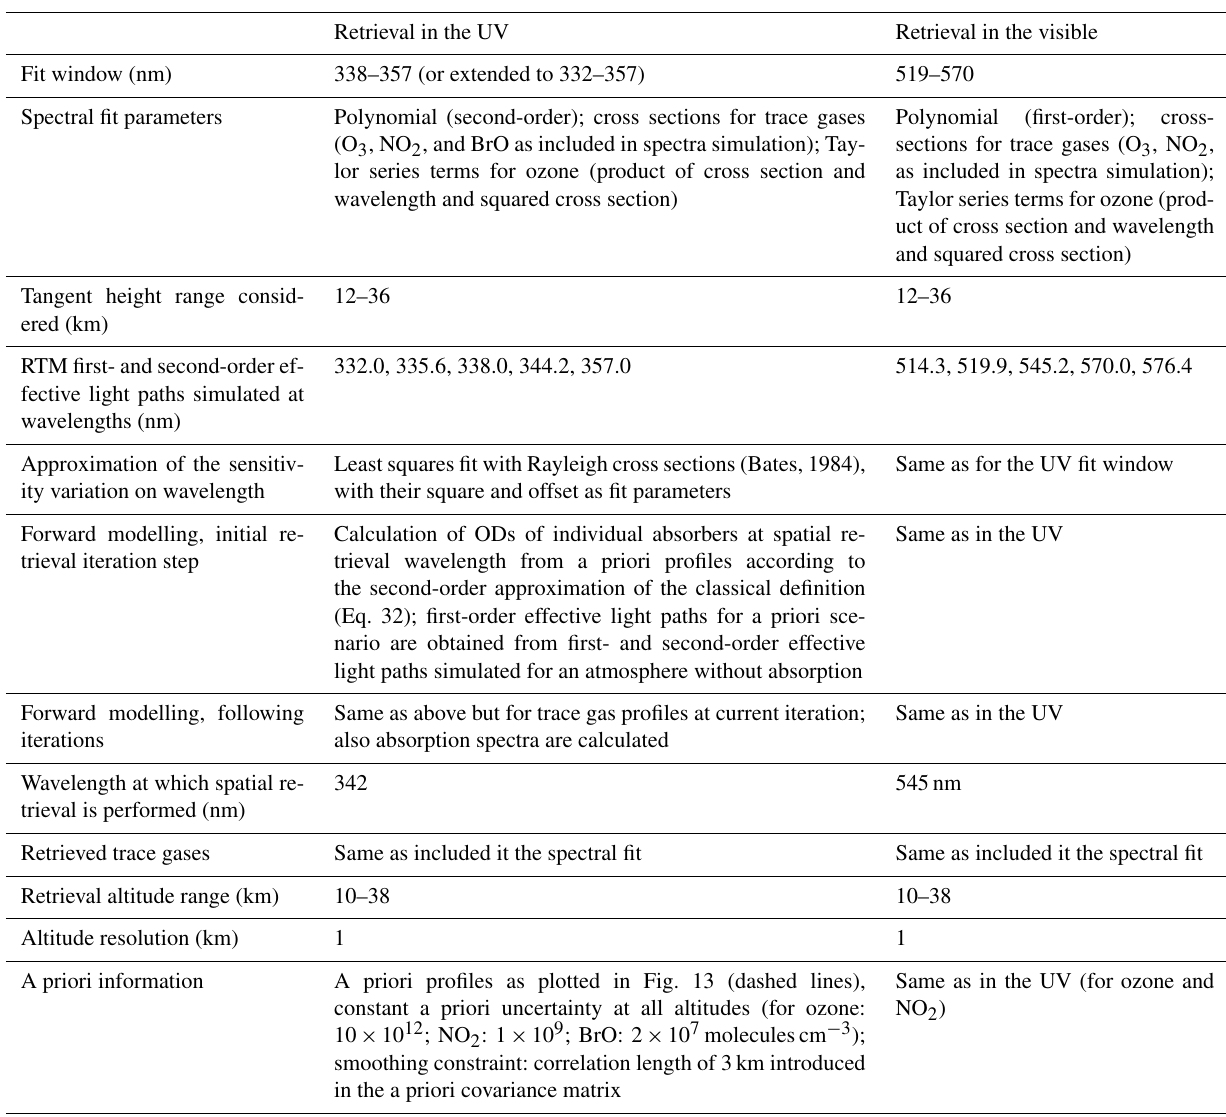
A priori profiles as plotted in Fig. 13 (dashed lines), constant a priori uncertainty at all altitudes (for